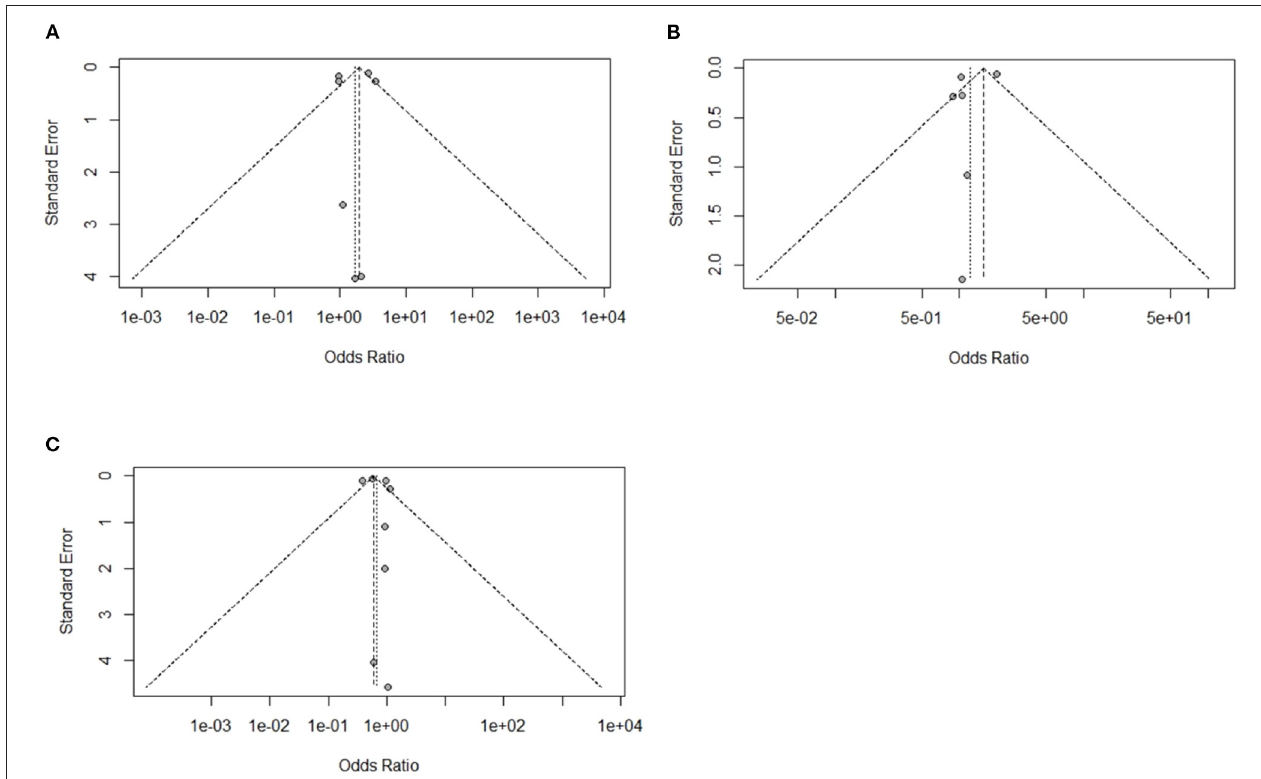
FIGURE 5 | Funnel plots representing the effect of heat stress on immunity level. (A) Asymmetric funnel plot indicates the possible biases of our selected IgA related journal, (B) asymmetric funnel plot indicates the possible biases of our selected IgG related journal, and (C) asymmetric funnel plot indicates the possible biases of our selected IgM related